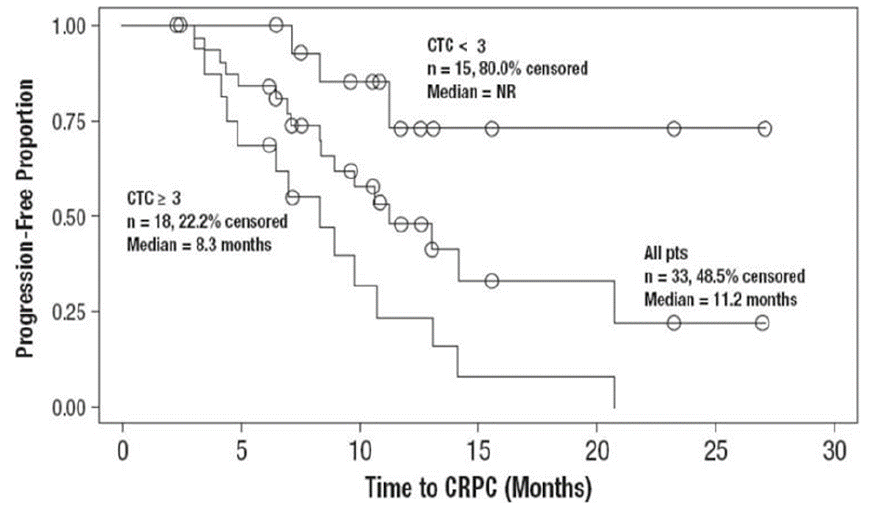
Figure 3. CTC count and time to castration-resistant prostate cancer. Kaplan-Meier survival curves in HSPC (reprinted from [42] with permission of